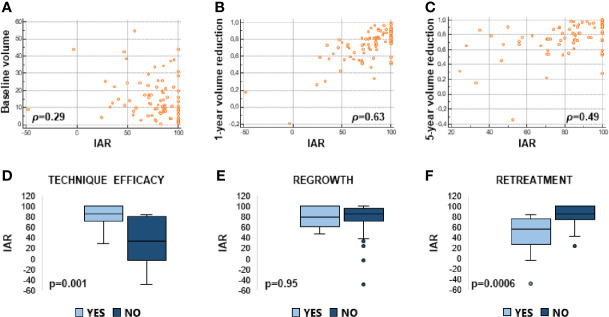
Linear correlations between IAR and baseline volume (A), IAR and 1-year volume reduction ratio (B), IAR and 5-year volume reduction ratio (C). Box plots representing median IAR (min -max) in cases of technical efficacy vs inefficacy (D); presence or absence of regrowth (E); retreatment vs no retreatment (F).